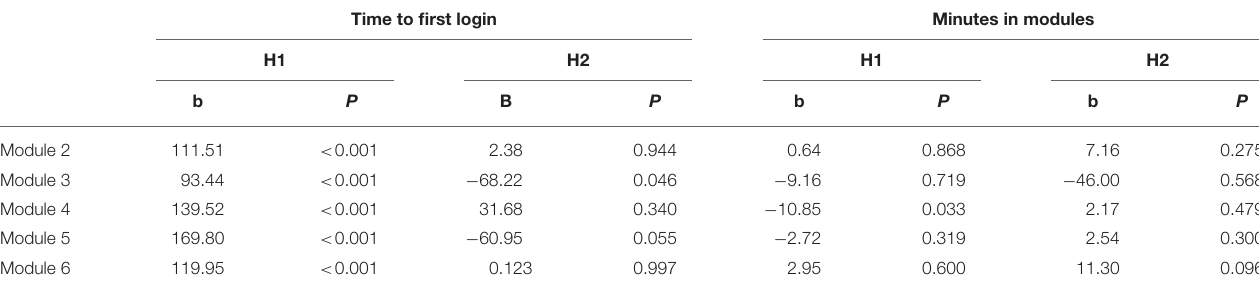
TABLE 5 | Time to first login predicted and minutes in the modules by being in the randomization group or not (hypothesis H1) and receiving SMS or not in the randomized group (hypothesis H2). Time to first